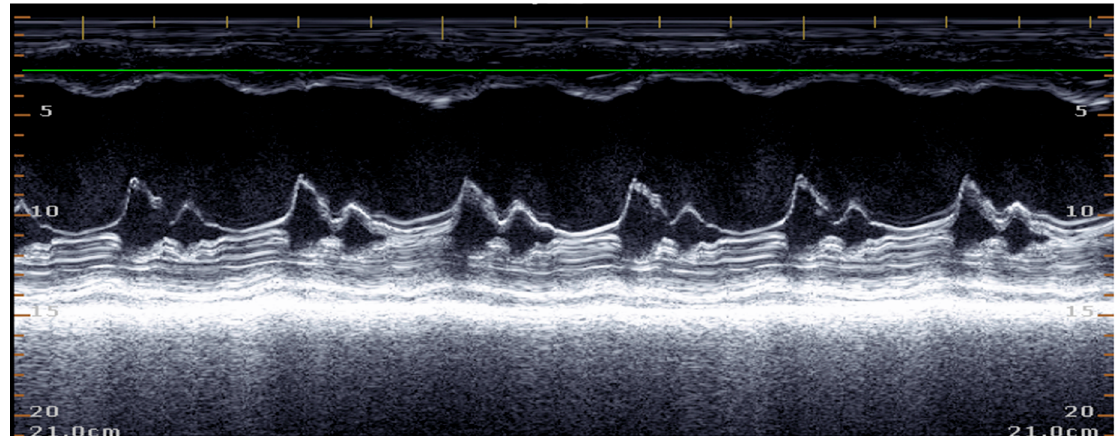
Figure 15. Increased mitral septal separation in a canine patient with DCM.